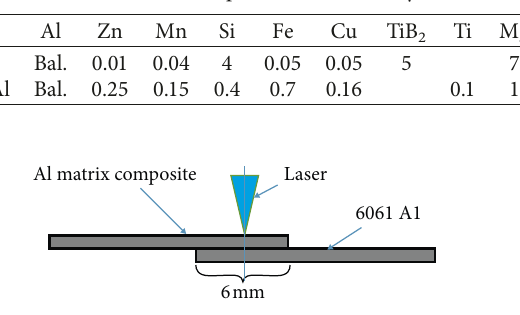
Figure 1: Schematic diagram of the laser welding process. Table 2: Parameters of the orthogonal test.